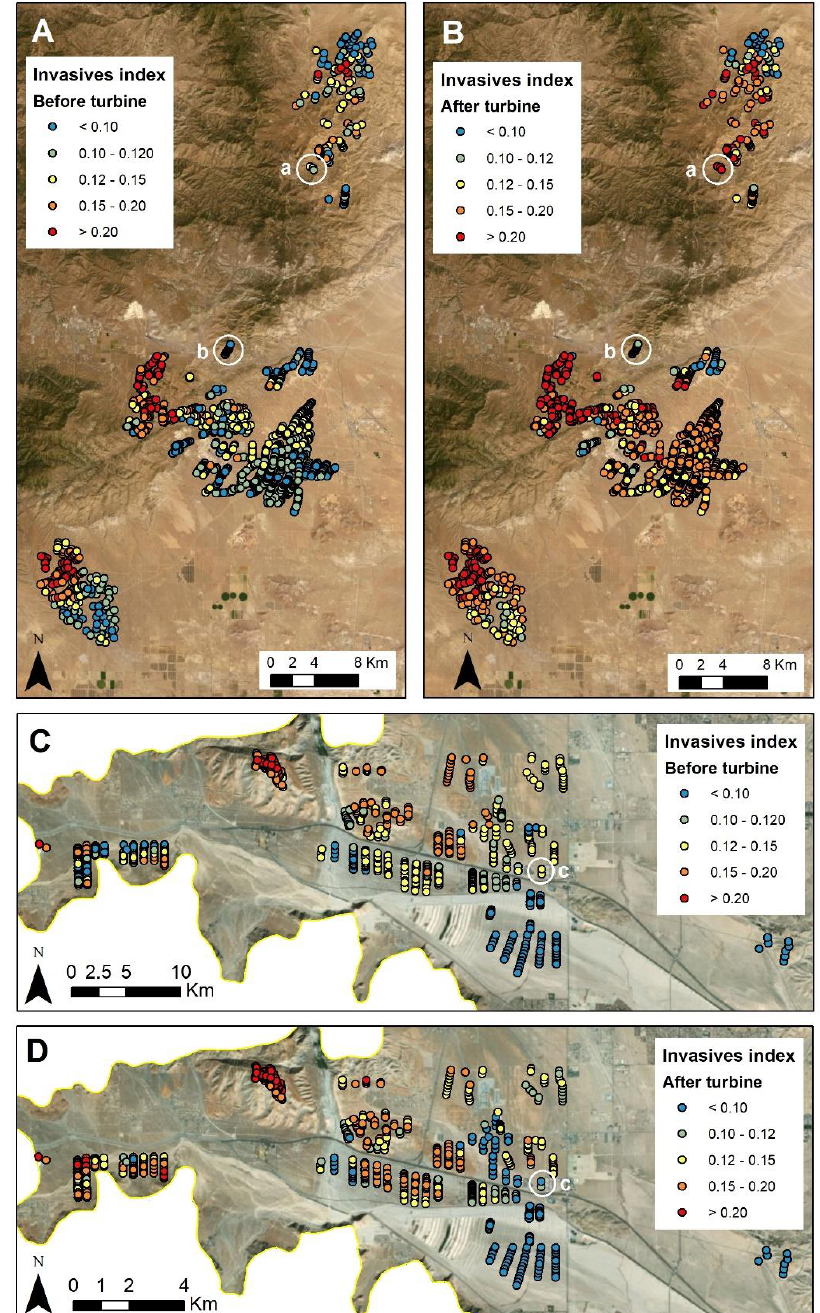
Figure 4. Early Season Invasives (ESI) index values before and after turbine construction, ( A ) Tehachapi before, ( B ) Tehachapi after, ( C ) Desert Hot Springs before, and ( D ) Desert Hot Springs after. Index Figure 4. Early-season invasives (ESI) index values before and after the turbine construction: ( A ) Tehachapi before the turbine construction, ( B ) Tehachapi after the turbine construction, ( C ) Desert classification values indicate the likelihood of presence: none < 0.10, low 0.10–0.12, moderate 0.12–0.15, Hot Springs before the turbine construction, and ( D ) Desert Hot Springs after the turbine high 0.15–0.20, and very high > construction. Index classification values indicate the likelihood of presence: none (<0.10), low (0.10 –